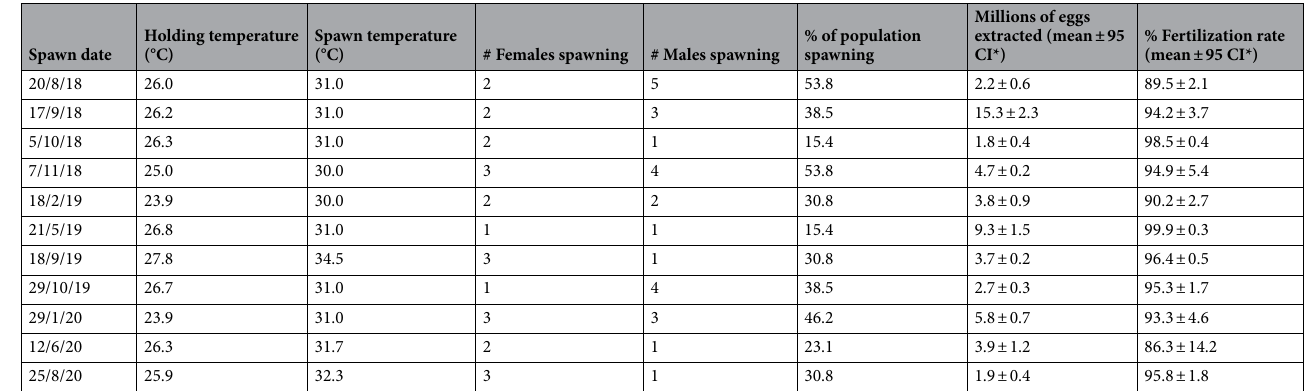
Table 1. Date and associated data from 11 successful spawning events between 20 August 2018 and 25 August 2020 using a common pool of 13 D. antillarum broodstock. Number of eggs extracted and fertilization rates reflect a 95% confidence interval (n = 3 counts per range). * CI confidence interval.